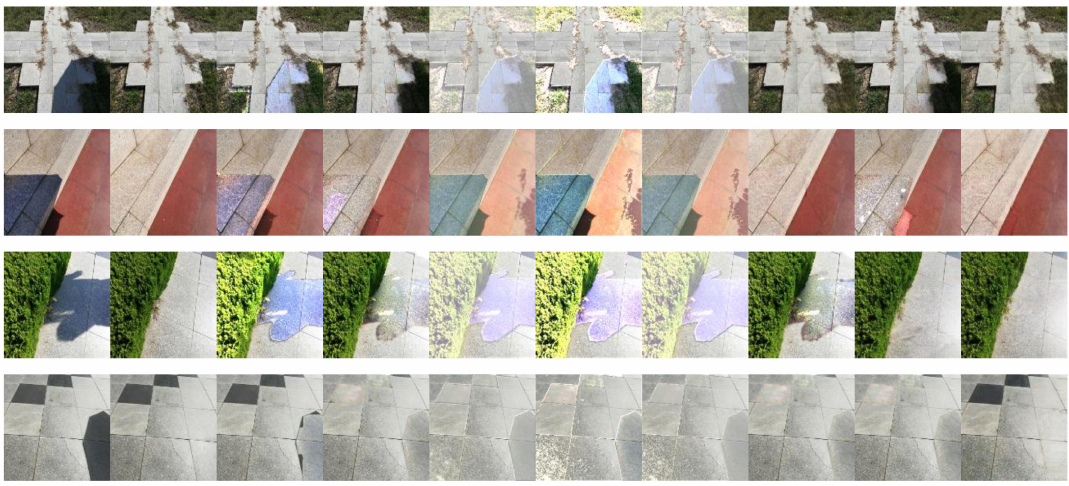
Figure 5. Schematic diagram of shadow removal in special